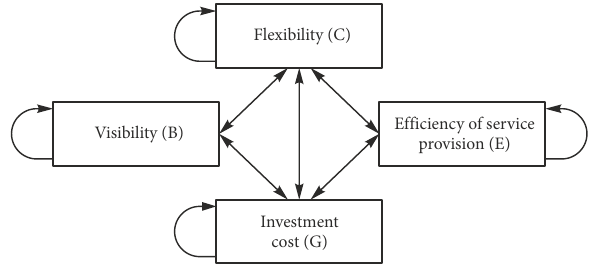
Figure 9. Relationship between dimensions preferred by Terminal